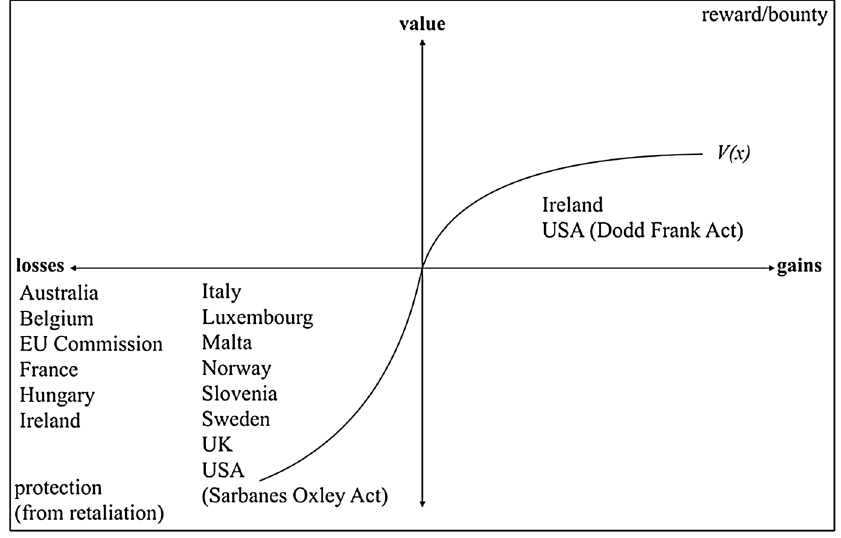
Fig. 3 Typical value function in prospect theory where an outcome x is weighted by a value v and the origin represents the reference point or status quo; legislation is added to the corresponding